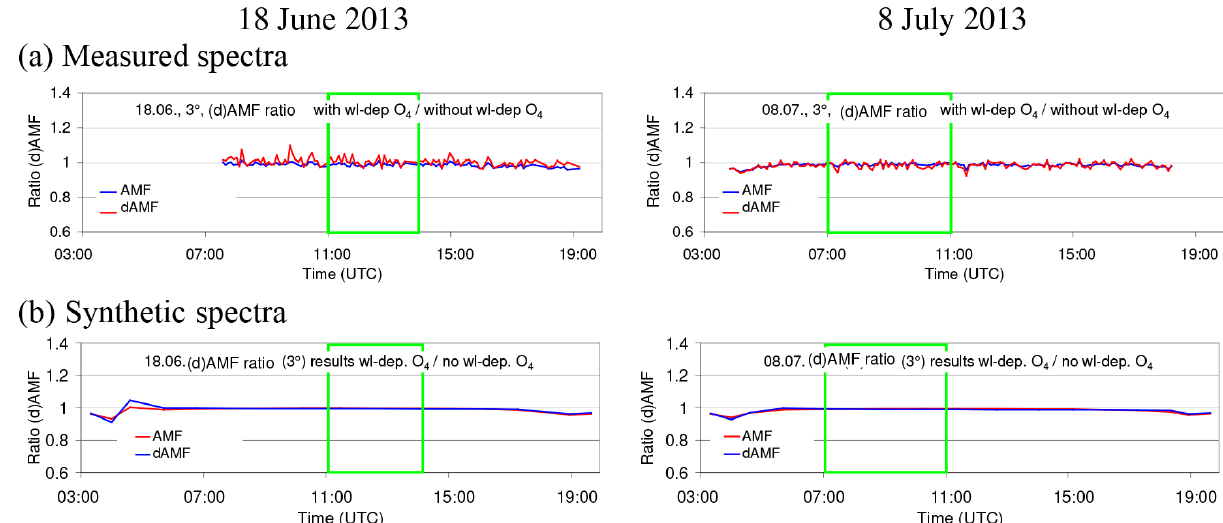
Figure A21. Ratios of the O 4 (d)AMFs derived for the analysis with a second O 4 cross section (accounting for the wavelength dependence) vs. those for the standard analysis (only one O 4 cross section) for both selected days ( a : results for spectra measured by the MPIC instrument; b : results for synthetic spectra when taking into account the temperature dependence of the O 4 cross section).